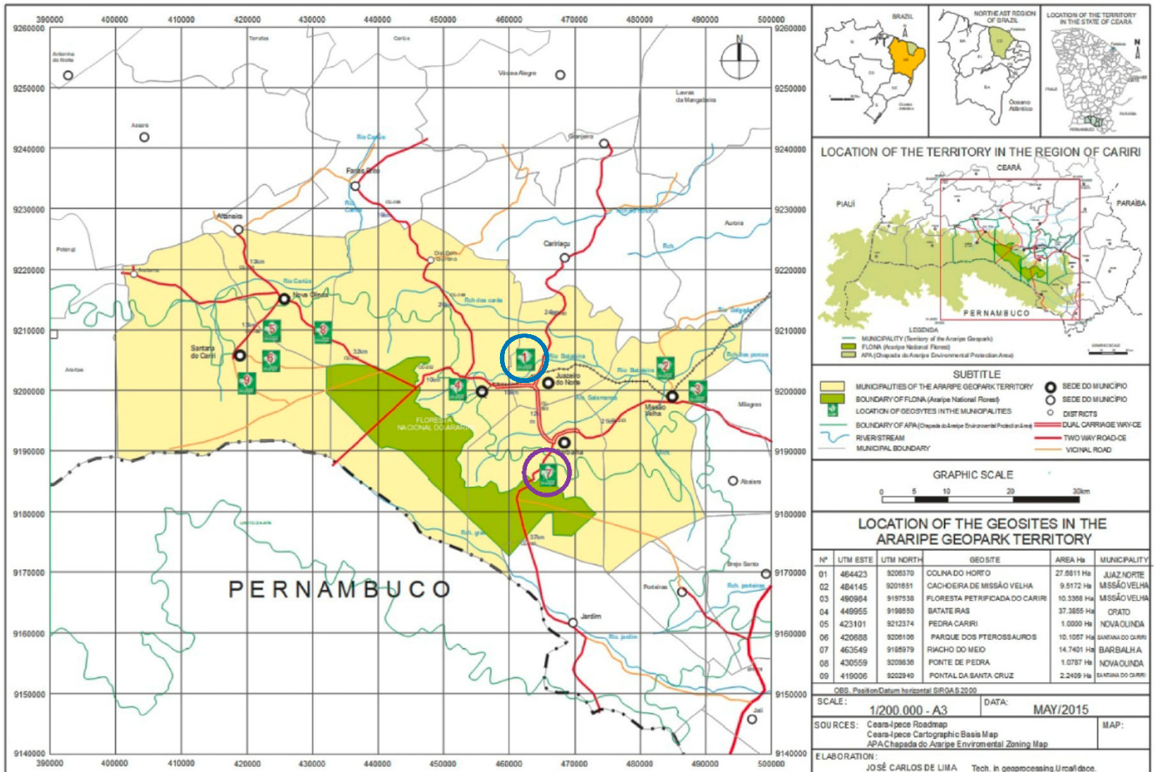
Figure 1. Map of the Territory and Geosites of Araripe United Nations Educational, Scientific and Cultural Organization (UNESCO) Global Geopark (UGG). Highlight in blue circle (1)—Santo Sepulcro Trail (Geosite Colina do Horto/Juazeiro do Norte City); Highlight in purple circle (7)—Riacho do Meio Trail in the homonymous geosite (Barbalha City). Source, Guimar ã es et al. (2018) [18]; adapted for the